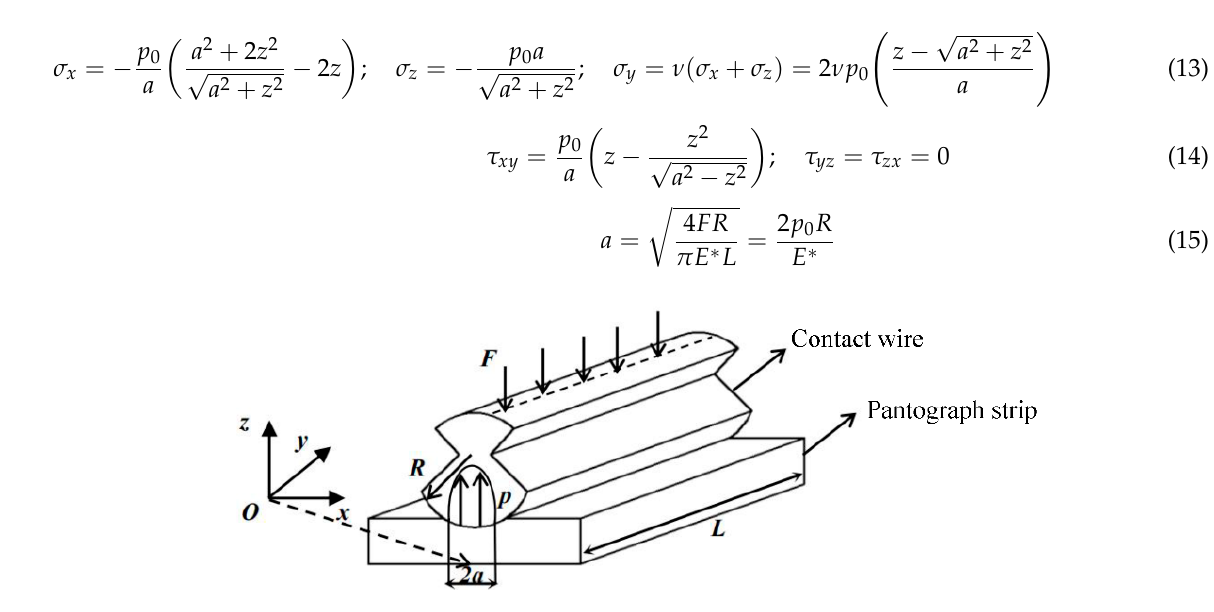
Figure 7. The pantograph–catenary contact model. Table 3. Definition of parameters of the pantograph–catenary contact model.